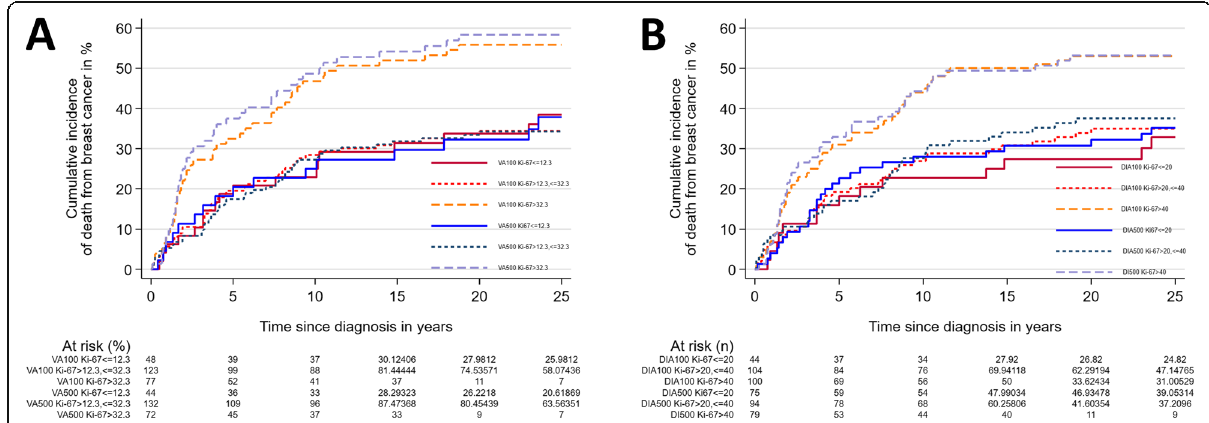
Fig. 7 Cumulative incidence of death from breast cancer. A Visual assessment (VA), Grays ’ test for VA100 (Low, Intermediate and High) P = 0.1062; Grays ’ test for VA500 (Low, Intermediate and High) P = 0.0500. B Digital image analysis (DIA), Gray ’ s test for DIA100 (Low, Intermediate and High) P = 0.3335; Grays ’ test for DIA500 (Low, Intermediate and High) P =